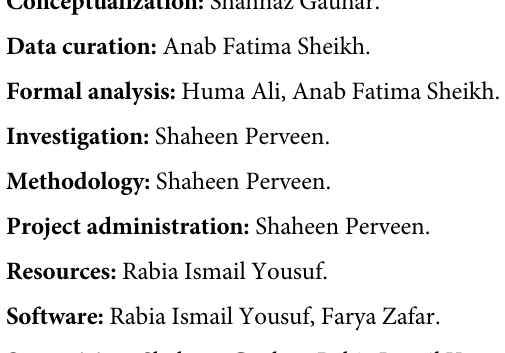
� given values are real number of adverse events on the basis of individual subject reporting. Statistically insignificant differences were found between